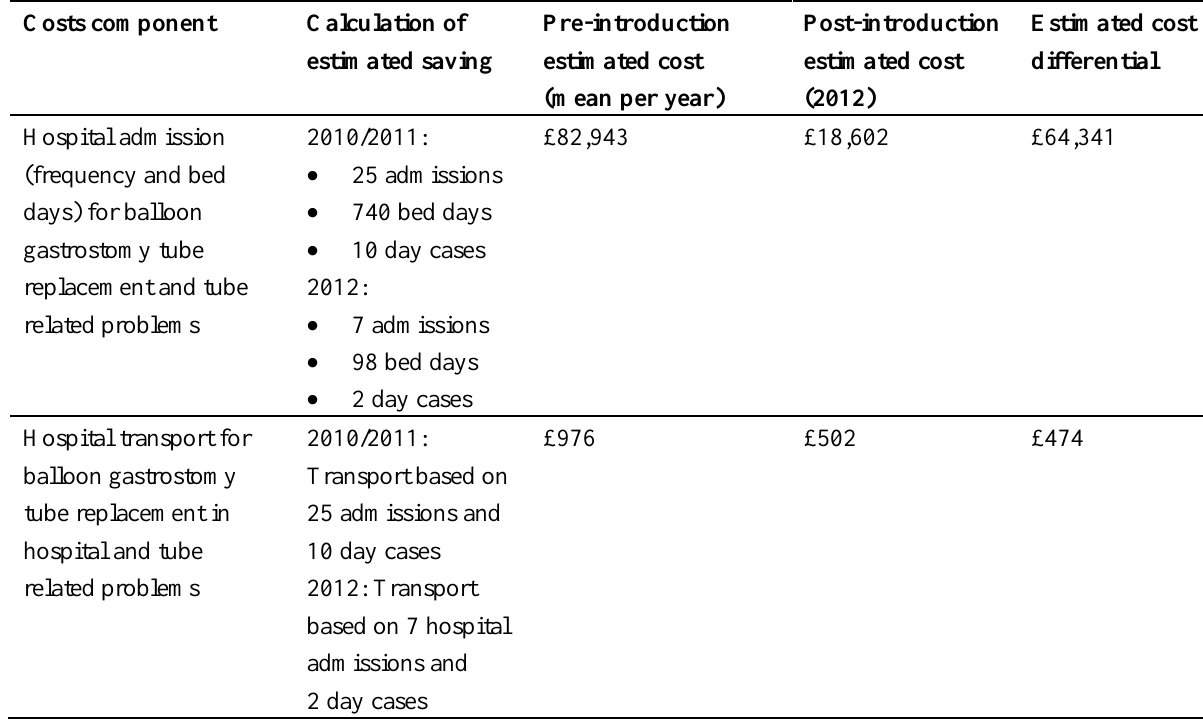
Table 3. Estimated costs of hospital admission pre and post introduction of the Home Enteral Nutrition Team ( n =